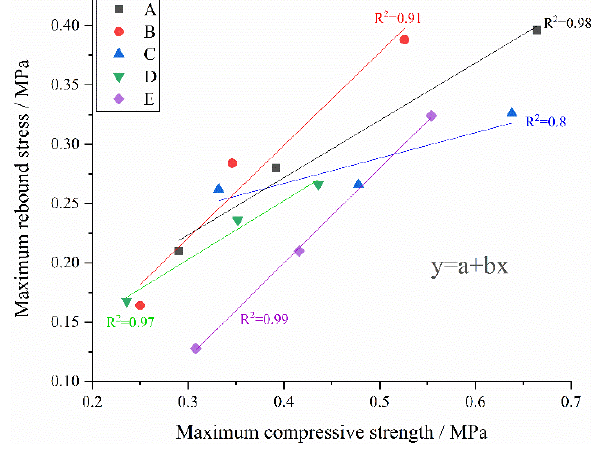
Figure 6. Relationship between maximum compressive strength and maximum rebound stress.